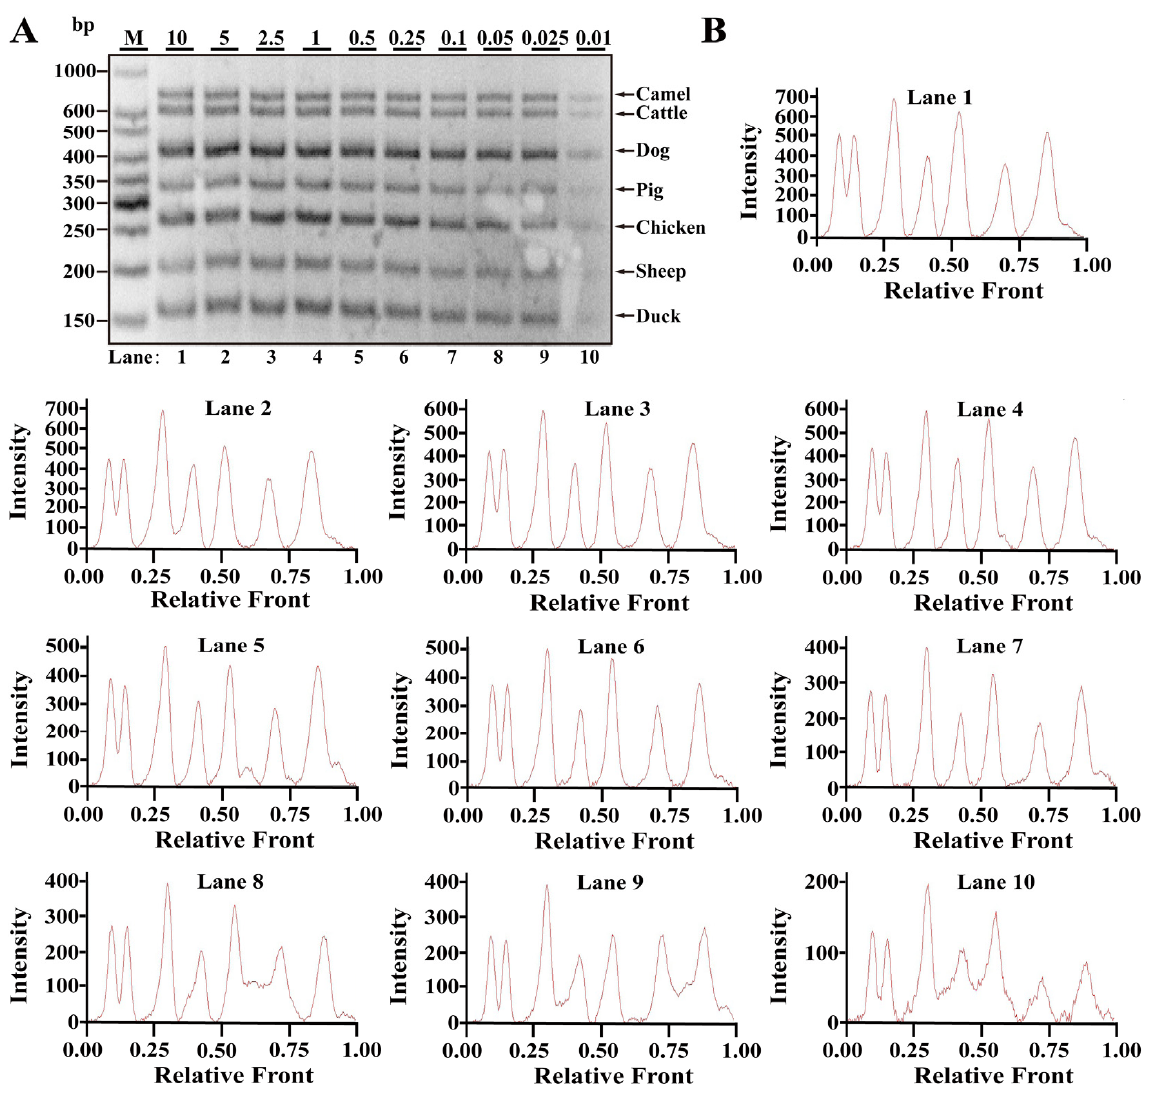
Figure 4. Validation of sensitivity of multiplex PCR assay in boiling meat tissues. ( A ) Gel image of PCR fragments amplified by multiplex PCR using premixed DNA contents of seven species (10, 5, 2.5, 1, 0.5, 0.25, 0.1, 0.05, 0.025 and 0.01 ng) with seven sets of target primers, respectively. ( B ) The corresponding electropherograms represent camel, cattle, dog, pig, chicken, sheep and duck in each lane. Lanes 1–10 are presented with labels (10, 5, 2.5, 1, 0.5, 0.25, 0.1, 0.05, 0.025 and 0.01) in ( A ). The value of number at the horizontal line means the relative position of peaks distant from the top of agarose gel. The value of number at the vertical line means the fluorescent intensity of DNA-bound dyes (4S GelRed Nucleic Acid Stain). Lane M is ladder DNA.